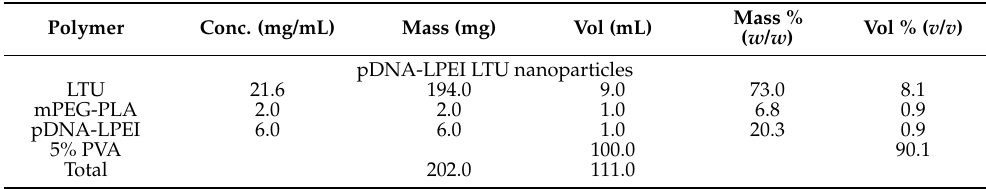
Table 2. Detailed compositions of LTU nanoparticle formulations (pDNA-LPEI nanoparticles) pro- duced using the double emulsion